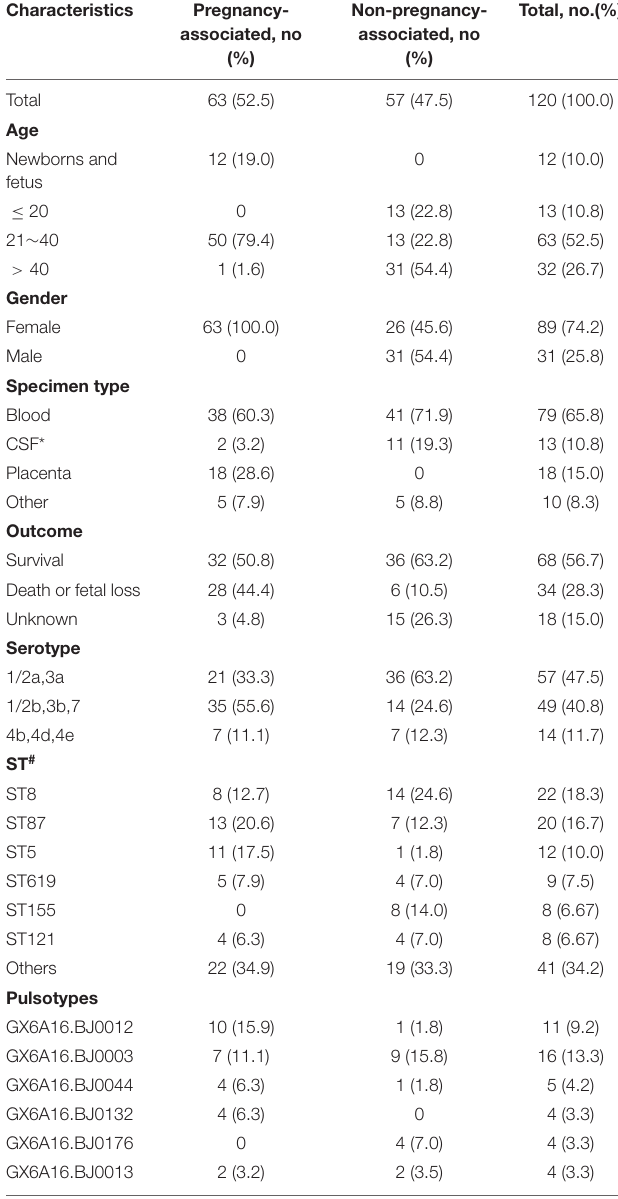
TABLE 1 | Characteristics of 120 isolates isolated from 120 cases in Beijing, China, between 2014 and